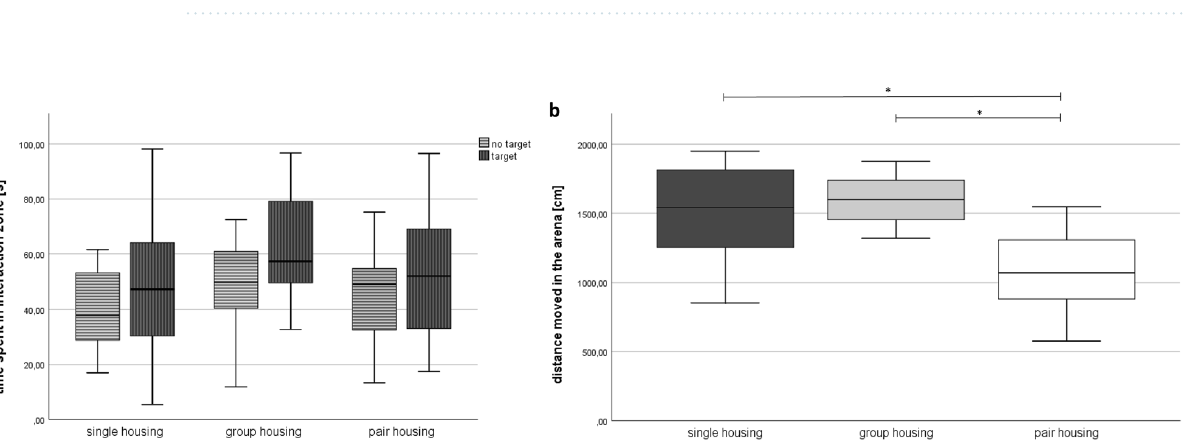
Table 1. Interaction and capture scores. Data are given as median (25th quartile–75th quartile): * p < 0.05, versus separated pair housing. Single housing: n = 16, group housing: n = 16, separated pair housing: n = 16.